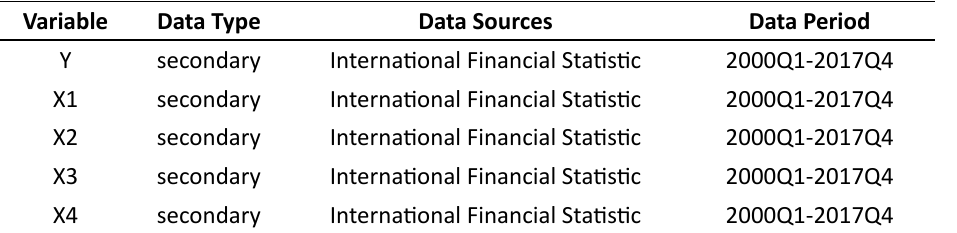
Table 1: Types and Data